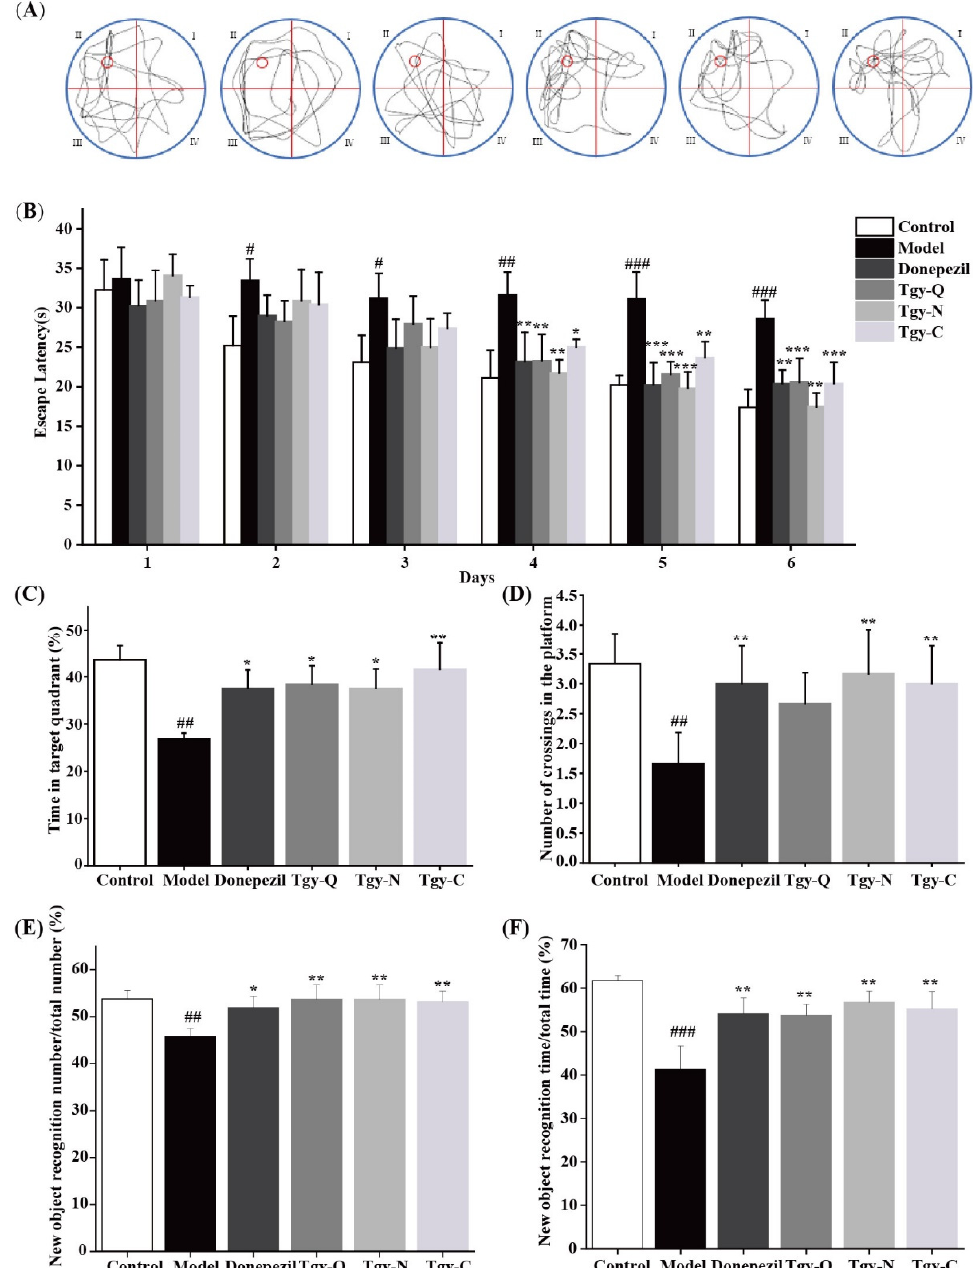
Figure 2. Tieguanyin extracts improve the cognitive ability. ( A ) Trajectory map of Morris maze in six groups of mice, the area of water maze circular pool was divided into four quadrants I, II, III, and IV, the target object was located in II area. ( B ) Escape latency of looking for invisible platform in six groups of mice. ( C , D ) Remaining time of target area and number of crossings in six groups of mice. ( E , F ) Effect of Tieguanyin extracts on APP/PS1 mice in new object recognition experiment. Donepezil group indicates positive control group ( n = 8, APP/PS1 mice), daily delivered with 1 mg/kg/day Donepezil in 0.25 mL Sterile by oral gavage for 70 days; Control group ( n = 10, C57BL/6 J mice), Model, Tgy-Q, Tgy-N, Tgy-C groups each has 8 APP/PS1 mice, which was administrated with corresponding sterile water or different extracts dissolved in 0.25 mL sterile water by daily oral gavage for 70 days. Data are mean ± SEM. # p < 0.05, ## p < 0.01, and ### p < 0.001 different from control group, * p < 0.05, ** p < 0.01, and *** p < 0.001 different from model group. The escape latency refers to the time it takes for the mice to find the setting platform from the time they enter the water; that is, the shorter the escape latency, the stronger the